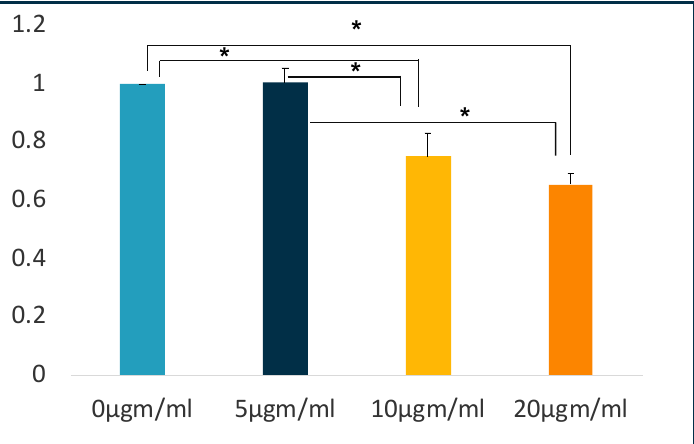
Figure 2. Quantification of Alizarin-Red. LPS affected the osteogenic capabilities of PDLSCs. The cells were cultured under osteogenic medium for four weeks in the presence of different concentrations of LPS. * p ≤ 0.05.